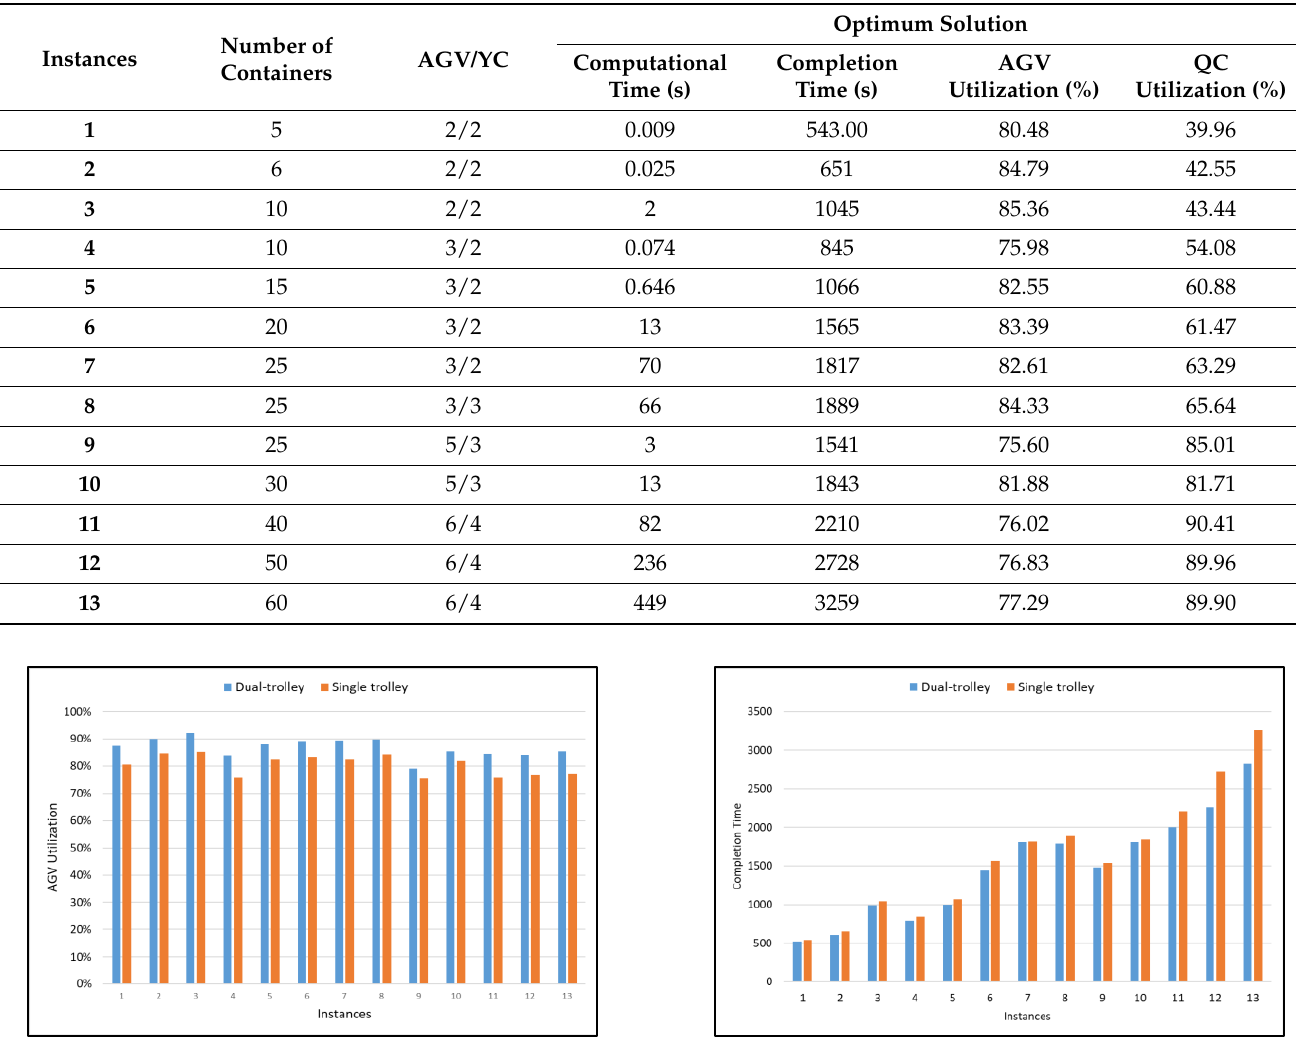
Table 3. Computational results for single-trolley QCs.